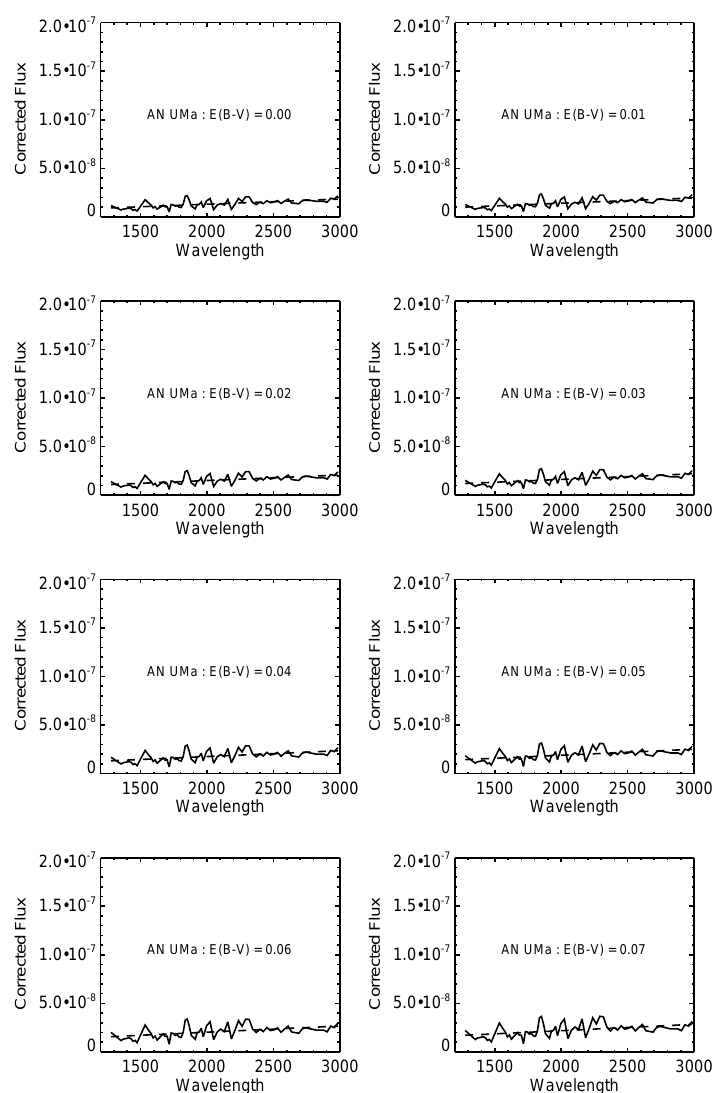
Fig. 8. Reddening determination for AN